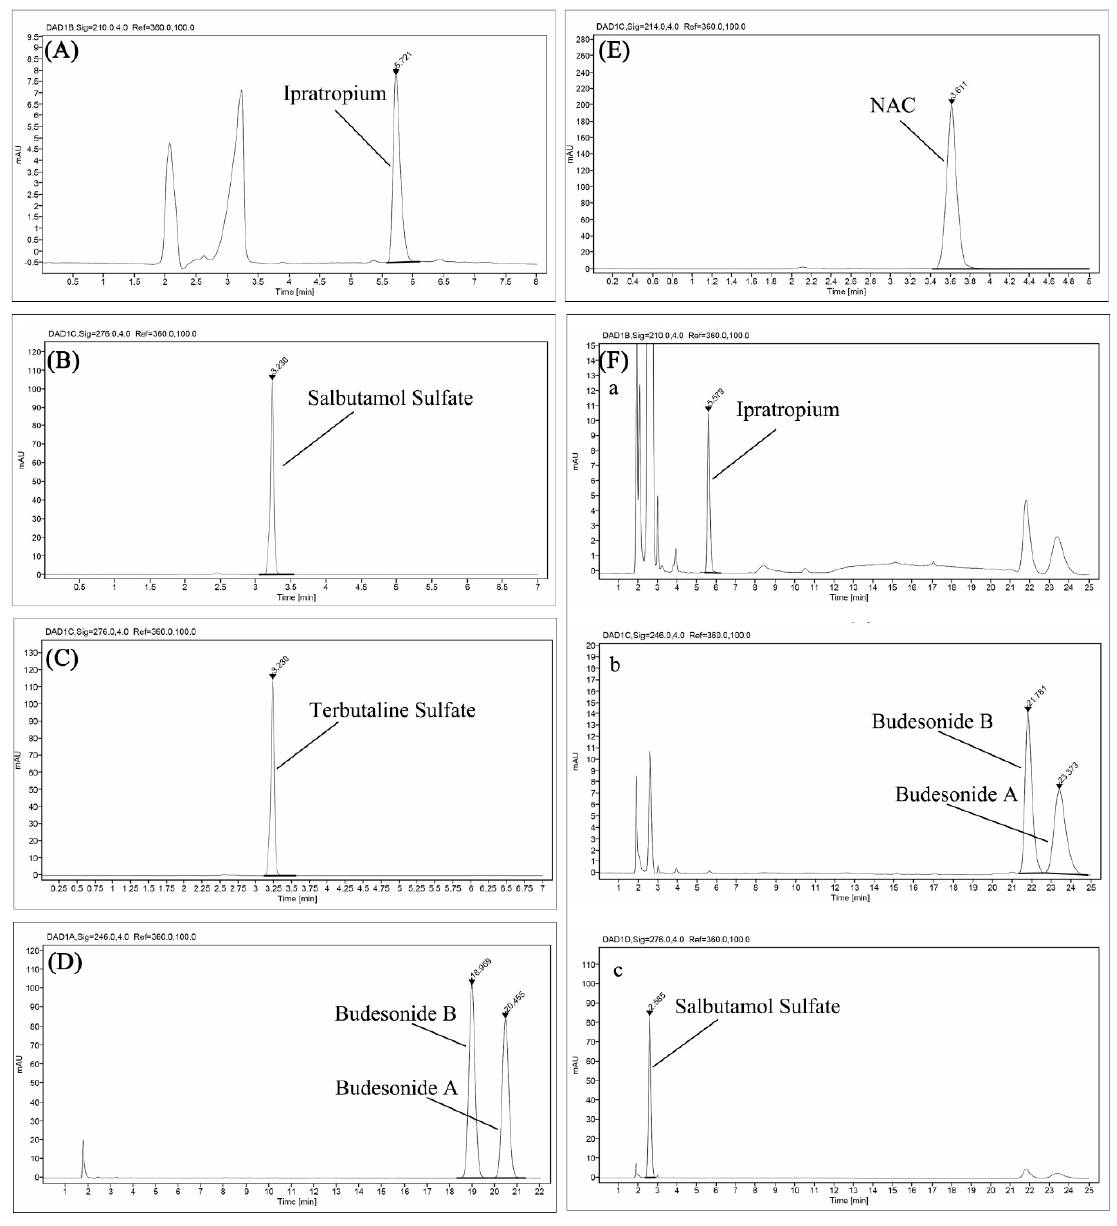
Figure 3. HPLC chromatograms of ( A ) Atrovent ® (210 nm), ( B ) Ventolin ® (276 nm), ( C ) Bricanyl ® (276 nm), ( D ) Pulmicort ® (246 nm), ( E ) Fluimucil ® (214 nm), and ( F ) Atrovent ® / Ventolin ® / Pulmicort ® (( a ) 210 nm for ipratropium bromide, ( b ) 246 nm for budesonide, and ( c ) 276 nm for salbutamol sulfate)).